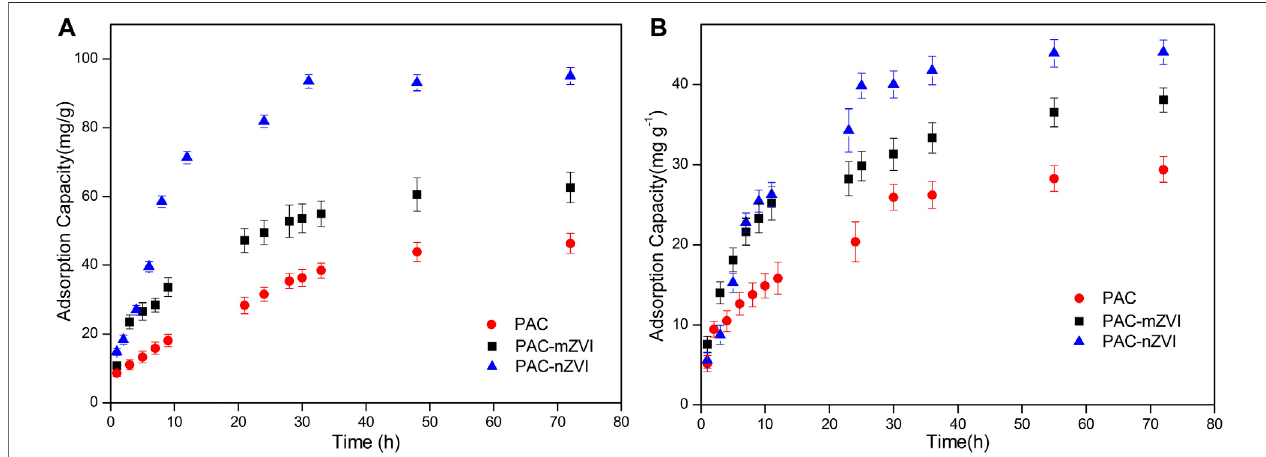
FIGURE 5 | Effects of contact time on the removal of CV (A) and MB (B) by PAC, PAC-mZVI, and PAC-nZVI adsorbents.